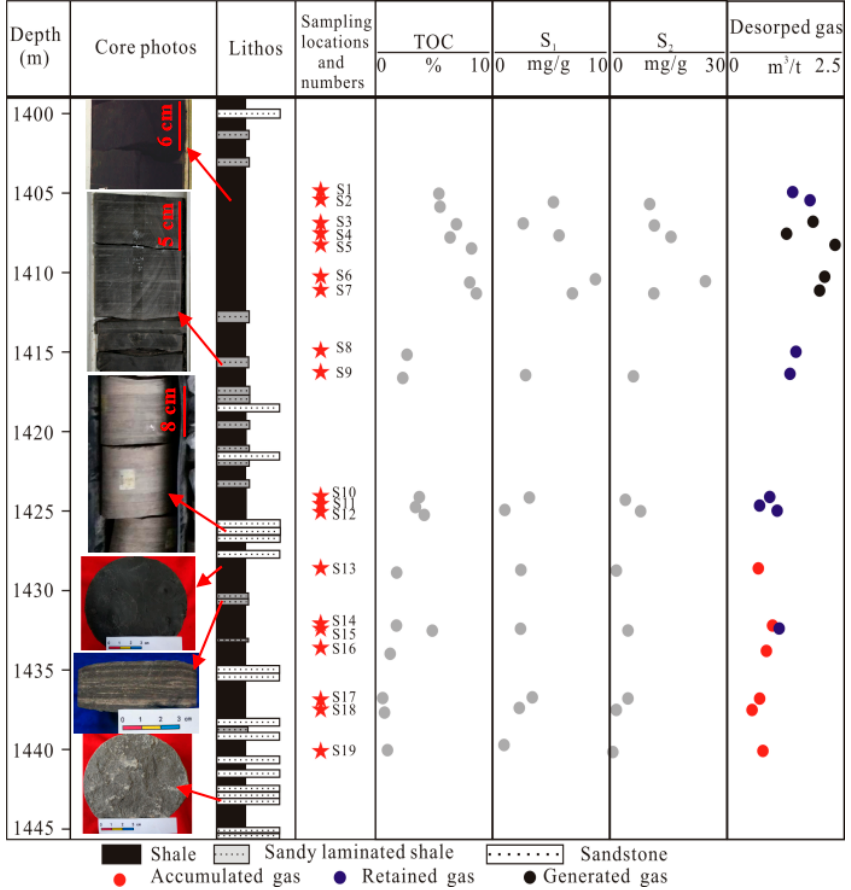
Figure 7. Histogram showing the cores, geological parameters and gas-type classifications.